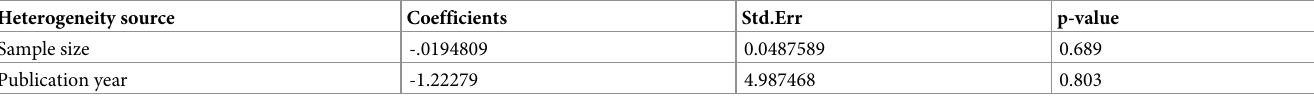
Table 2. A univariate meta-regression analysis of factors affecting between-study heterogeneity.